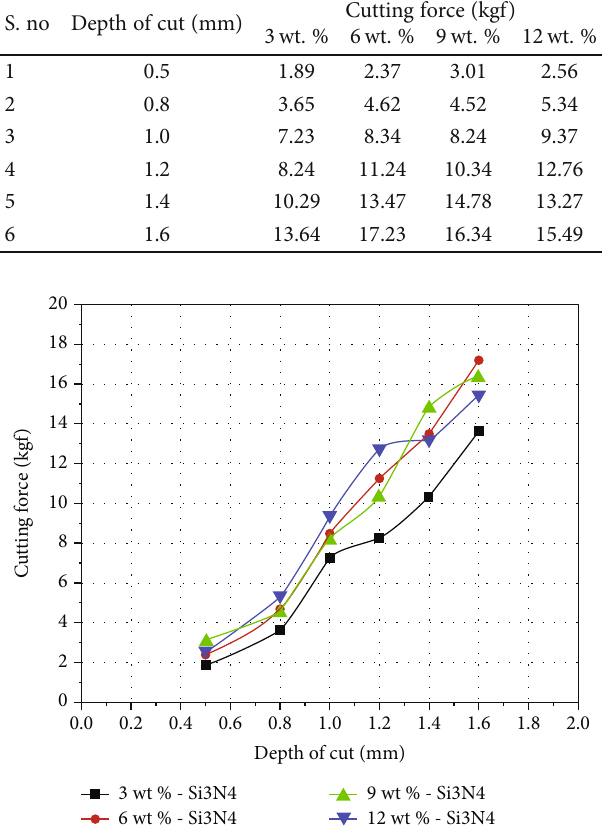
Figure 7: Depth of cut vs. cutting force (cutting speed 150m/min).